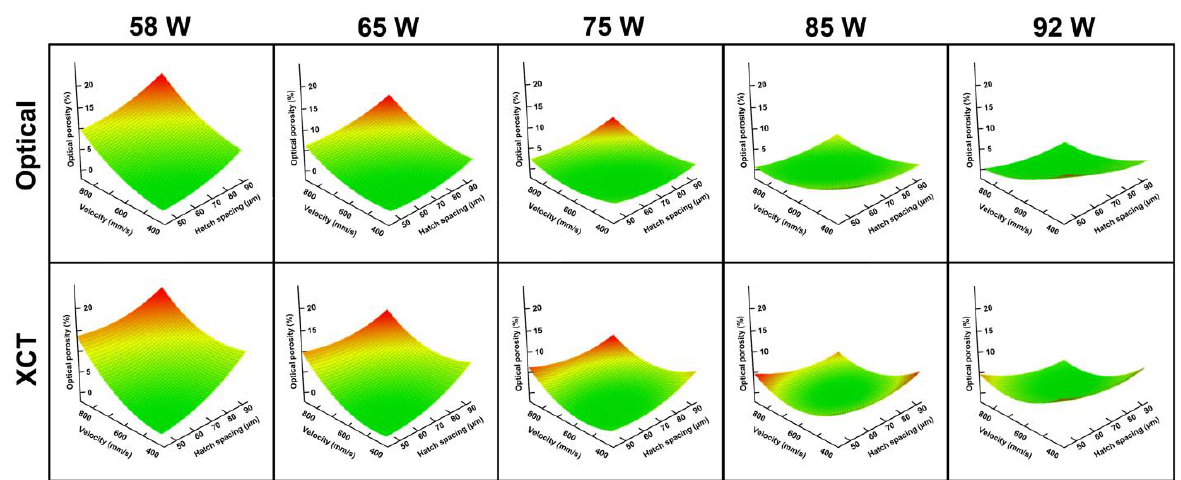
Figure 10. Prediction of porosity variation with power based on the optical and XCT models.